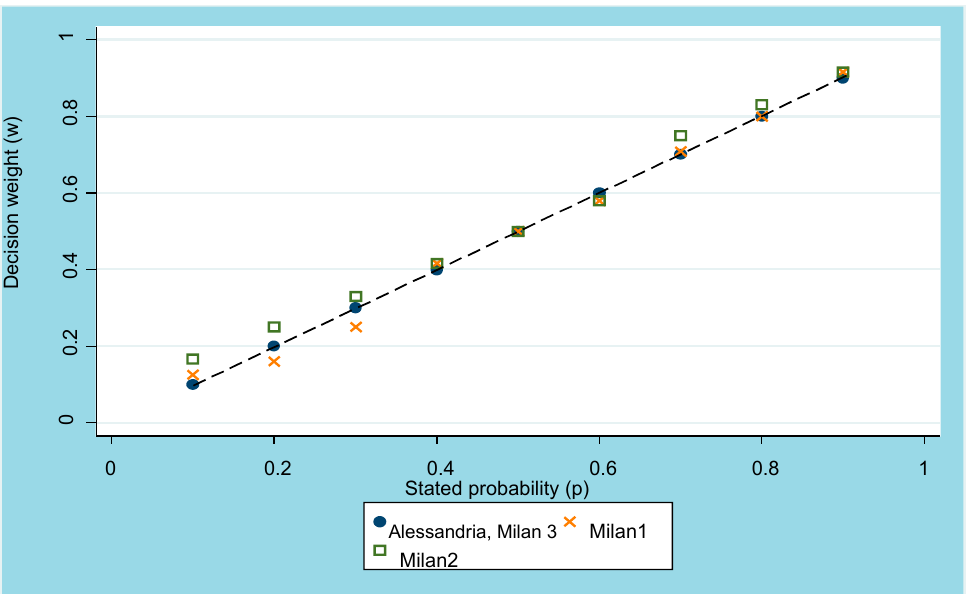
Figure 1. Median decision weights for risky prospects under a linear value function. Note: Median decision weights for risk corresponded to the 45 degree line in Alessandria and Milan 3, they were equal to 0.125, 0.167, 0.25, 0.416, 0.5, 0.58, 0.7, 0.8, 0.917 in Milan 1 and to 0.167, 0.25, 0.33, 0.417, 0.5, 0.58, 0.75, 0.83, 0.917 in Milan 2 at each probability level starting from 0.1 to 0.9, with 0.1 increments.